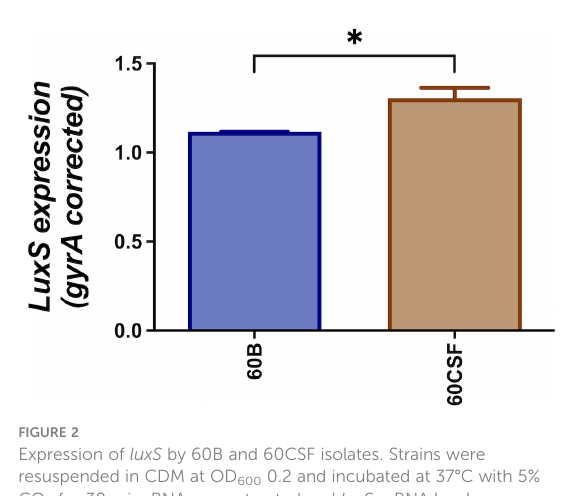
FIGURE 2 Expression of luxS by 60B and 60CSF isolates. Strains were resuspended in CDM at OD 600 0.2 and incubated at 37°C with 5% CO 2 for 30 min. RNA was extracted and luxS mRNA levels were analyzed by qRT-PCR using gyrA rRNA as an internal control (see Materials and Methods). Data are mean OD 600 ± standard error mean (SEM) from three biological replicates. Signi fi cance of differences in gene expression between isolates was determined using two-tailed Student ’ s t test; * P <